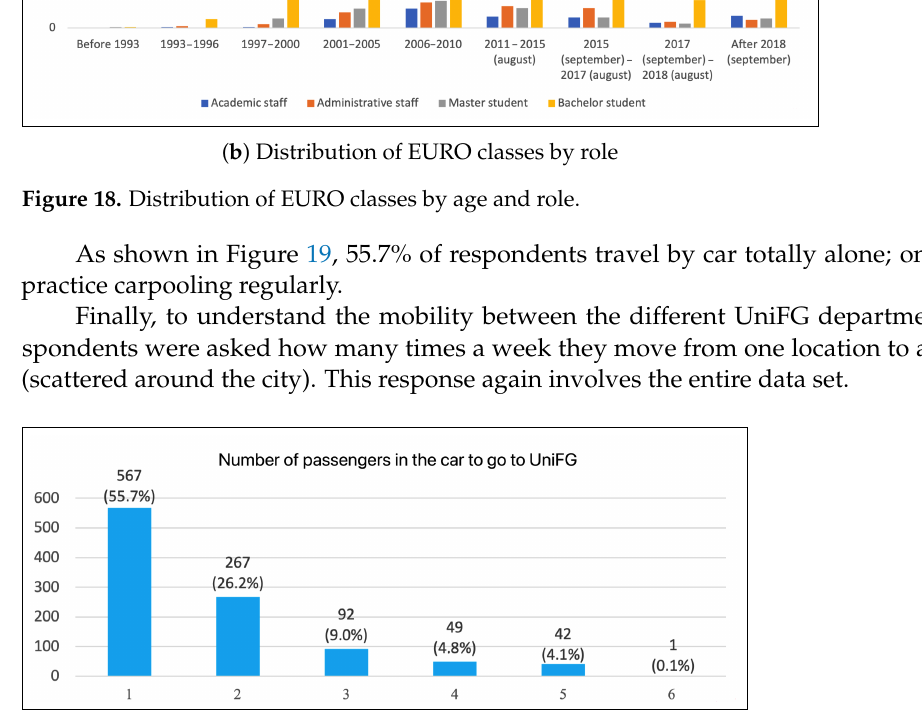
Figure 19. Number of passengers per